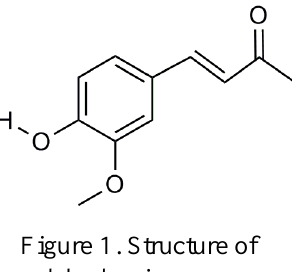
Figure 1. Structure of